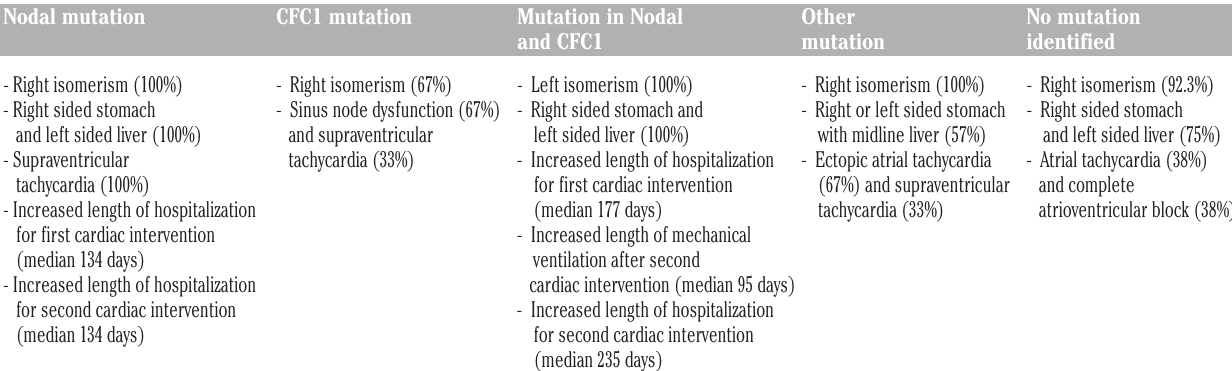
Table 4. Comparison of gene mutations by genetic subgroup. Nodal mutation CFC1 mutation Mutation in Nodal Other No mutation and CFC1 mutation identified - Right isomerism (100%) - Right isomerism (67%) - Left isomerism (100%) - Right isomerism (100%) - Right isomerism (92.3%) - Right sided stomach - Sinus node dysfunction (67%) - Right sided stomach